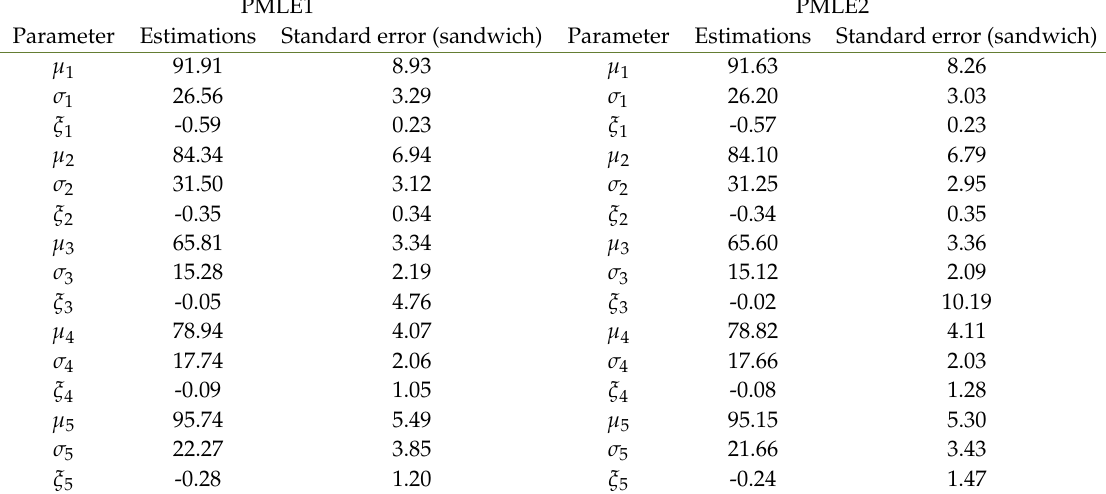
Table 2. Standard Error modified using Sandwich Estimator.